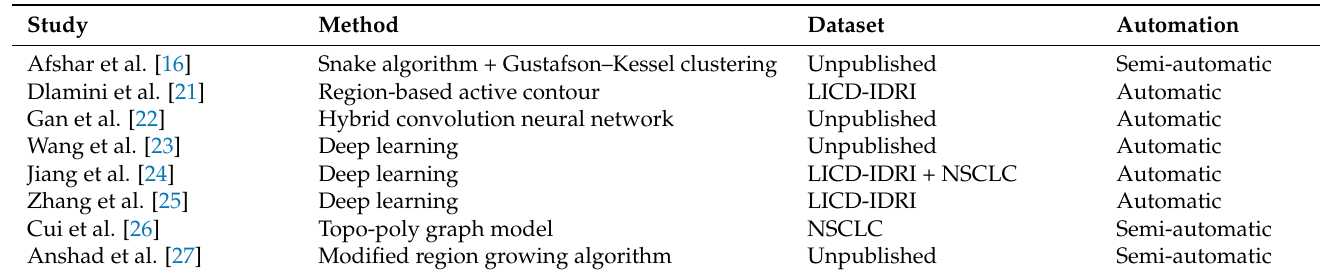
Table 1. Details of existing studies on tumor segmentation methods.